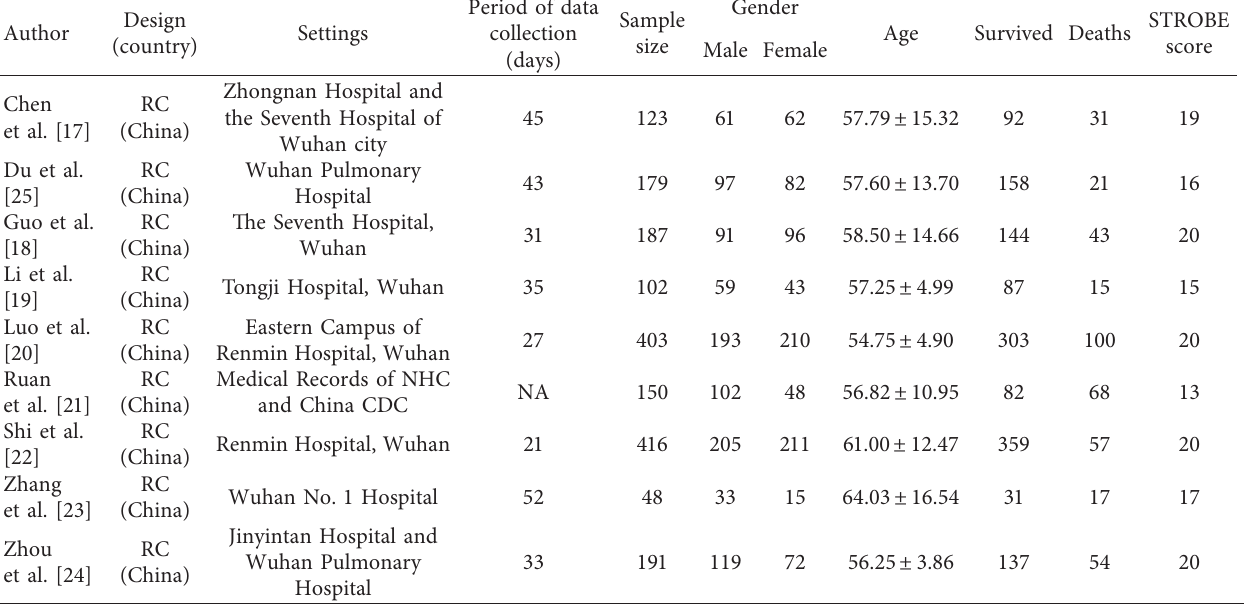
Table 1: Characteristics of the included